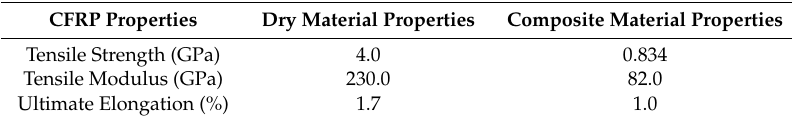
Table 4. Properties of carbon fiber reinforced polymer (CFRP) materials.